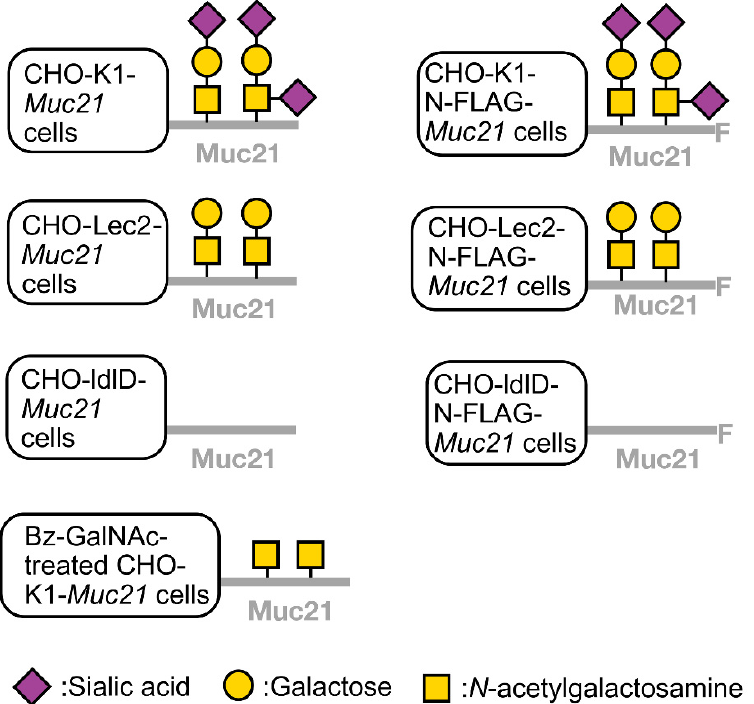
Figure 2. Schematics of putative glycoforms expressed by variants of Chinese hamster ovary (CHO) cells transfected with N-FLAG- Muc21. Muc21 with sialylated Thomsen–Friedenreich (T) antigen, i.e., consisting of N -Acetylgalactosamine (GalNAc), galactose (Gal), and sialic acid, is expected to be expressed on CHO-K1-pcDNA3.1-N-FLAG- Muc21 cells. Muc21 with T-antigen, i.e., GalNAc and Gal, is expected to be produced by CHO-Lec2-pCAGGS-N-FLAG- Muc21 cells because Lec2 cells cannot elongate sialic acid on their carbohydrate chain due to the downregulation of CMP-sialic acid Golgi transporter [12]. Non- O -glycosylated Muc21 is expected to be produced by CHO-ldlD-pCAGGS-N-FLAG- Muc21 cells because ldlD cells lack the ability to produce Gal and GalNAc due to the downregulation of UDP-Gal/UDP-GalNAc 4 epimerase [12]. In our flow cytometric analysis, using CHO-K1-pcDNA3.1-N-FLAG- Muc21 cells and their mock transfectants, hamster IgG and mAb 1A4-1 did not bind to mock transfectants or Muc21 transfectants. Anti-FLAG mAb and mAb 18A11 bound to CHO-K1-pcDNA3.1-N-FLAG- Muc21 cells but not to mock cells (Figure 3a). CHO-Lec2-pCAGGS-N-FLAG- Muc21 cells provided interesting information. mAb 1A4-1 strongly bound to CHO-Lec2-pCAGGS-N-FLAG- Muc21 cells, whereas mAb 18A11 did not (Figure 3b). These results strongly suggest that mAb 18A11 binds to sialylated T-Muc21 and mAb 1A4-1 binds to T-Muc21. These assumptions were confirmed through a comparison of antibody bindings before and after sialidase treatment of CHO-K1-pcDNA3.1-N-FLAG- Muc21 cells. mAb 18A11 did not bind CHO-Lec2-pCAGGS-N-FLAG- Muc21 cells or sialidase-treated CHO-K1-pcDNA3.1-N-FLAG- Muc21 cells. These cells express glycans without sialic acids, so T-antigens are present (Figure 3c). In the analysis using CHO-ldlD-pCAGGS-N-FLAG- Muc21 cells, hamster IgG, mAb 1A4-1 and mAb 18A11 bound to Muc21 transfectant to the same extent as to the mock transfectant (Figure 3d). This result suggests that both mAb 1A4-1 and mAb 18A11 do not bind to unmodified